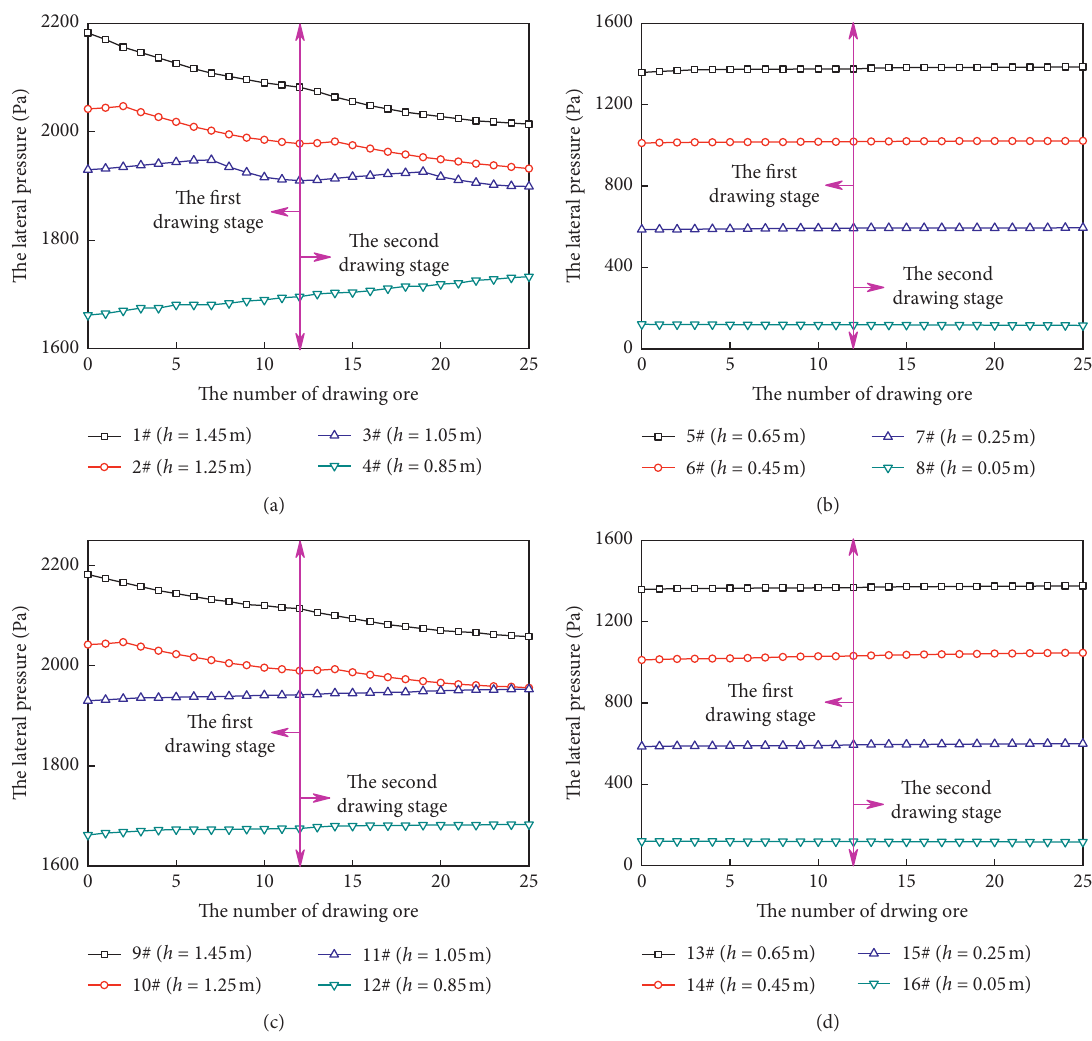
Figure 9: The relationship between the number of drawing ore and the values of lateral pressure with scheme